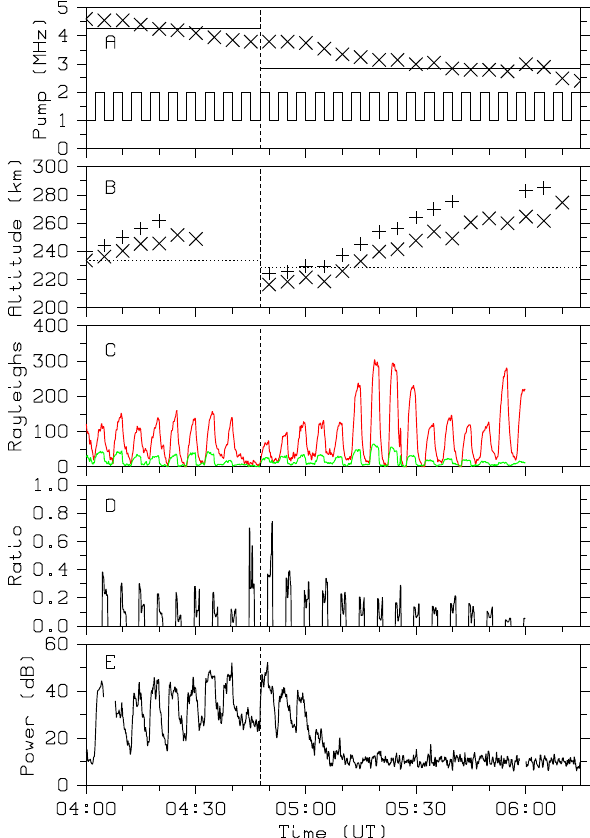
Fig. 1. Results from 25 February 2004. The vertical dashed line in all panels separates the third (left) and second (right) gyro-harmonic parts of the experiment. Panel A shows the pump frequency used (solid lines), ionospheric critical frequency ( × ) and pump cycle (square waves). Panel B shows the altitude of the respective gyro- harmonics (dotted lines), the pump wave reflection altitude mea- sured by the Digisonde (+), and the upper-hybrid resonance alti- tude ( × ) . Panel C shows the calibrated optical emission enhance- ment above background for 630 (red line) and 557.7 (green line) nm. Panel D shows the ratio of I(557.7)/I(630). Panel E shows the Kodiak radar backscatter power at